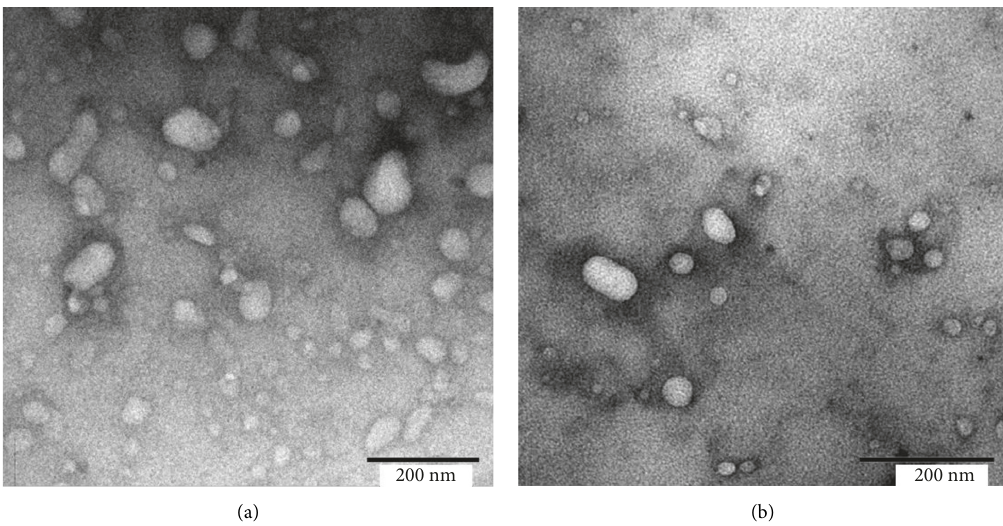
Figure 2: Transmission electron microscope images of Tf-LPHN (a) and Ctrl-LPHN (b) loaded with α -mangostin (Bar: 200nm). Table 1: Characterization of lipid-polymer hybrid nanoparticles entrapping α -mangostin ( n � 3).